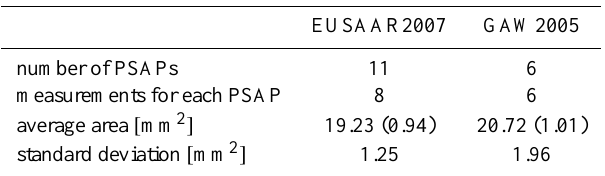
Table 7. Measured PSAP spot areas. The ratio of measured spot areas to the reference spot area of 20.43mm 2 is given in parenthe- ses.